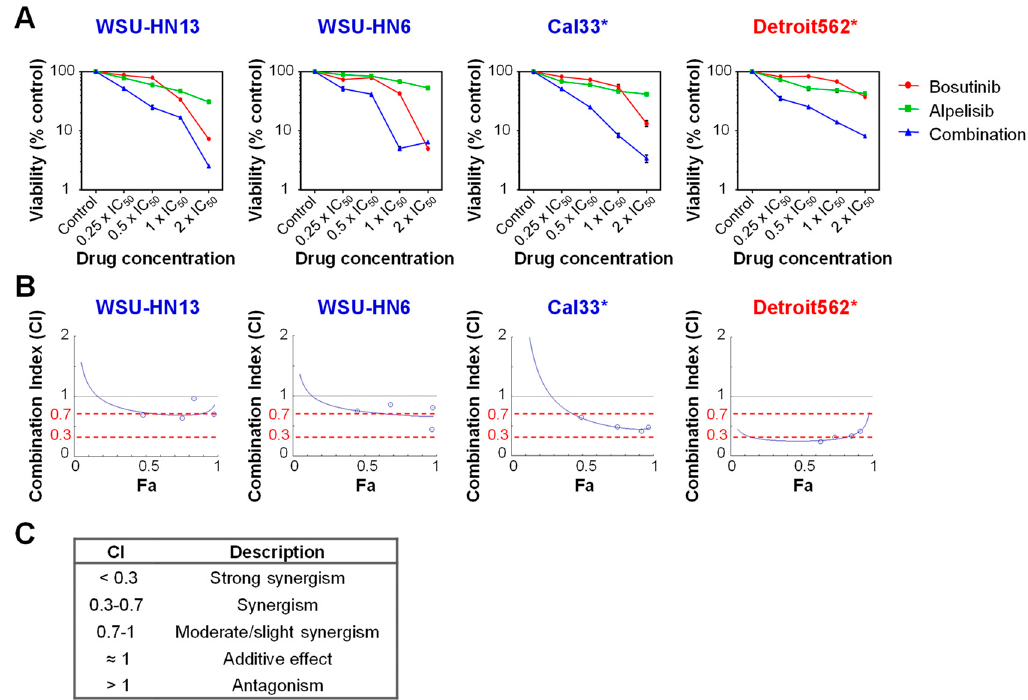
Figure 6. Sensitivity of HNSCC cell lines to Bosutinib in combination with Alpelisib. ( A ) Cell viability, as measured by XTT of the indicated cell lines treated with Bosutinib, Alpelisib and their combination at the indicated amounts of their IC 50 dose. Data represents means ± SEMs (each concentration point was replicated four times within the experiment). ( B ) Fa–CI plots to measure the synergism of the combination of two drugs. Fa represents the fraction of the cells affected by the combination of both drugs (at the concentrations indicated in panel A), “0” being 100% cell survival and “1” being 0% cell survival. The Combination Index (CI) was calculated using Compusyn software and plotted for each combination. ( C ) Description of the CI values. * Cell lines with mutations in PIK3CA . In red are cell lines resistant to Bosutinib; in blue are cell lines sensitive to Bosutinib.